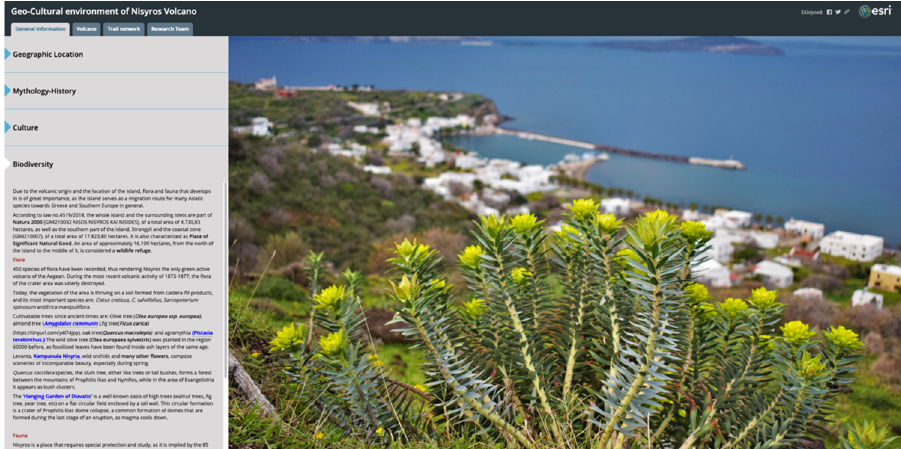
Figure 10 . Screenshot showing part of the narration about biodiversity found on the island ac- companied by high-resolution